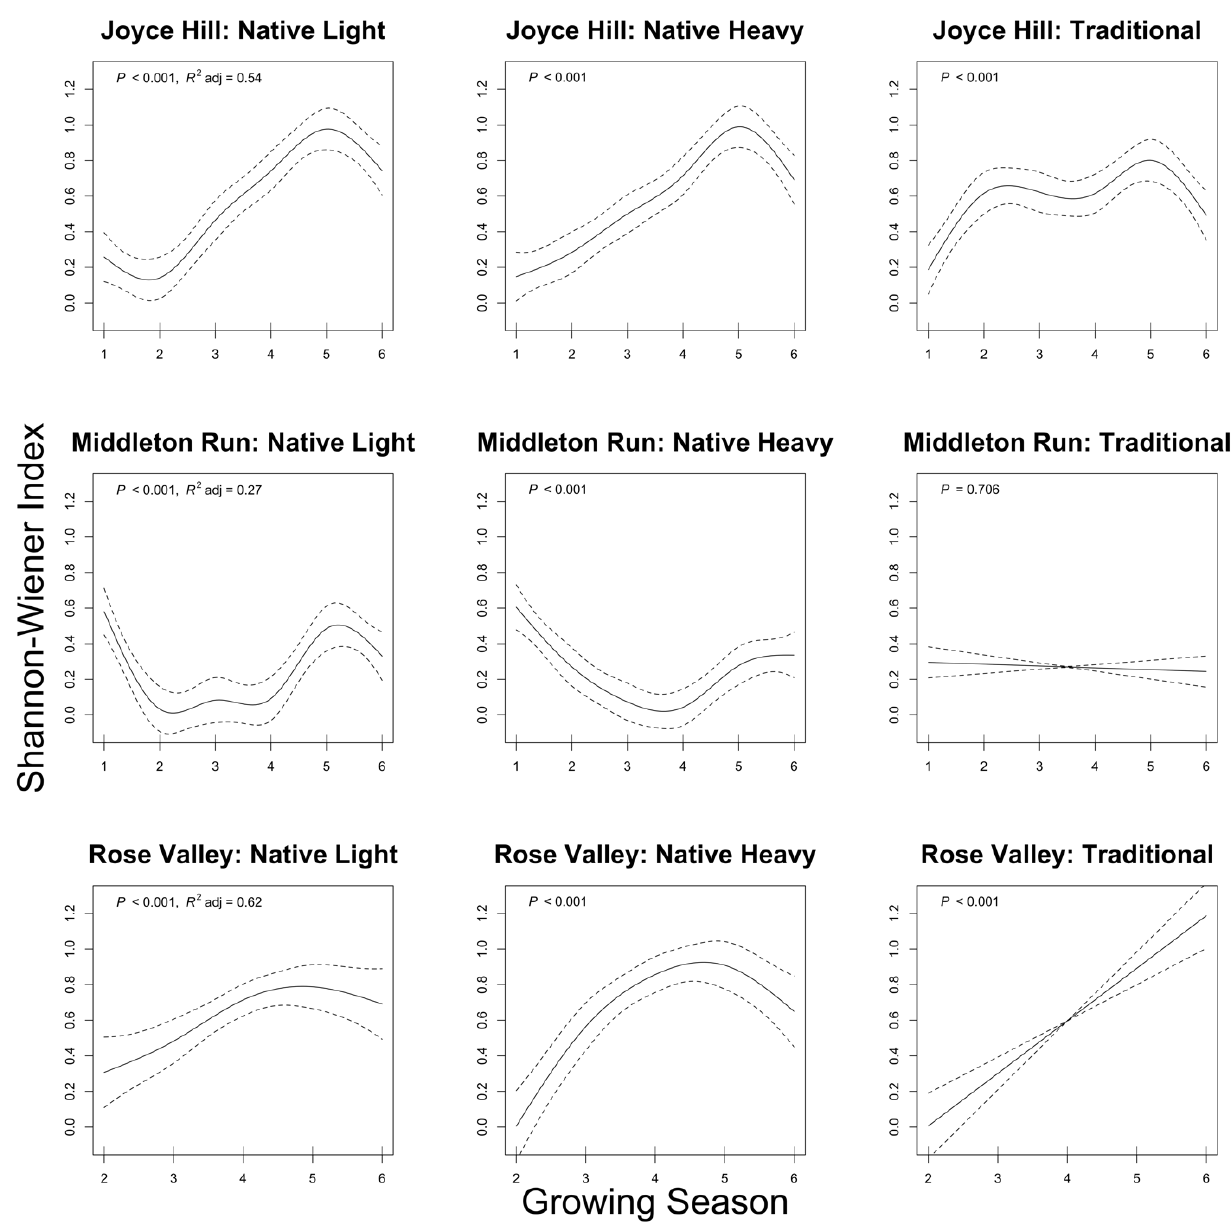
Figure 2. Shannon–Wiener diversity index over growing seasons for three seed mix treatments. Plot based on results from a term of a generalized additive model. Dotted lines represent two standard errors. Treatments within a single site are displayed within a single row. Adjusted R 2 values for seed treatment by growing season smooths are displayed in the first panel of each row.